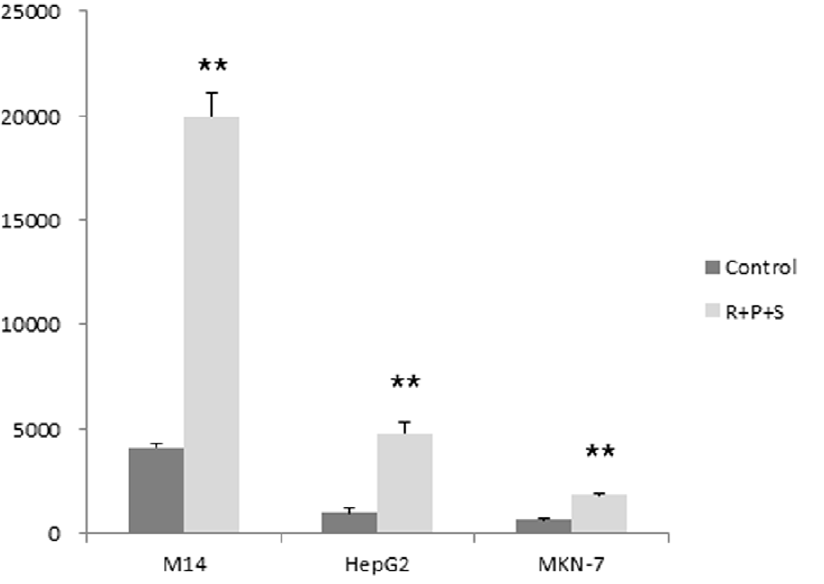
Figure 3. Induction of radioiodine uptake in M14, HepG2 and MKN-7 cells by treatment with the MEK, Akt and HDAC inhibitors. Cells were treated with RDEA119, perifosine and SAHA as described in Fig. 2, followed by incubation with Na 125 I for 1 hr. Parallel cells were additionally treated with the NIS blocker NaClO 4 to obtain non-specific radioiodine uptake/binding with the cells. Cells were then washed, lysed, and measured for radioactivity. Cell radioiodine uptake is presented as cpm/10 6 cells (on the y-axis of the figure) after correction for the non-specific radioiodine binding. Detailed experimental procedures are as described in the Materials and Methods. ‘‘Control’’, treatment of cells with vehicle; ‘‘R + P + S’’, treatment of cells with combination use of RDEA119, perifosine and SAHA. ** In comparison with control, p ,